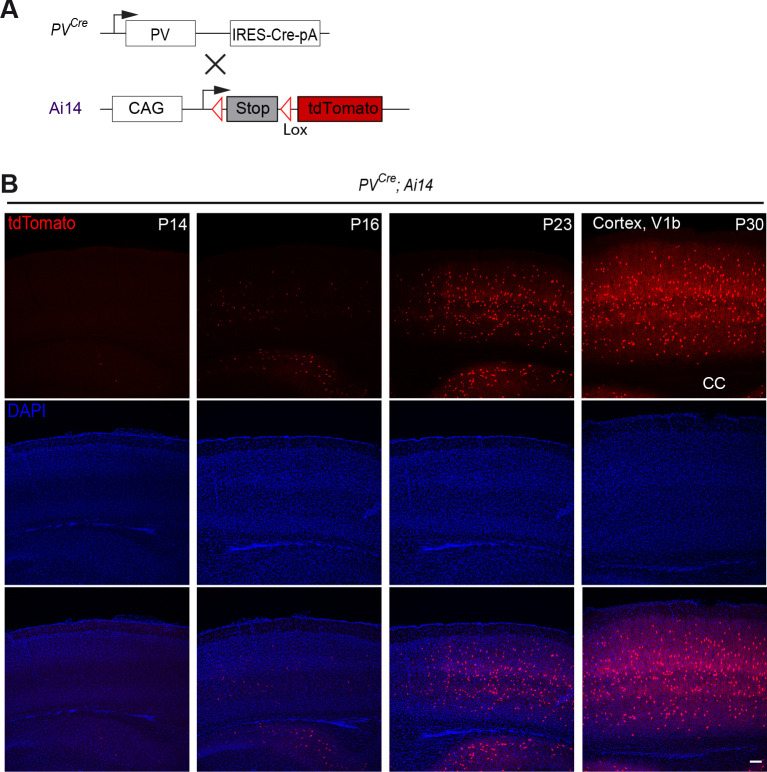
Late postnatal expression of Parvalbumin in cINs.(A) PV reporter mice (PVCre) were crossed to conditional Ai14 mice to label PV expressing cINs. (B) Representative photographs of primary visual cortex (V1) in PVCre;Ai14 mice at P14, 16, 23 and 30. CC = corpus callosum. Scale bars, 100 μm.